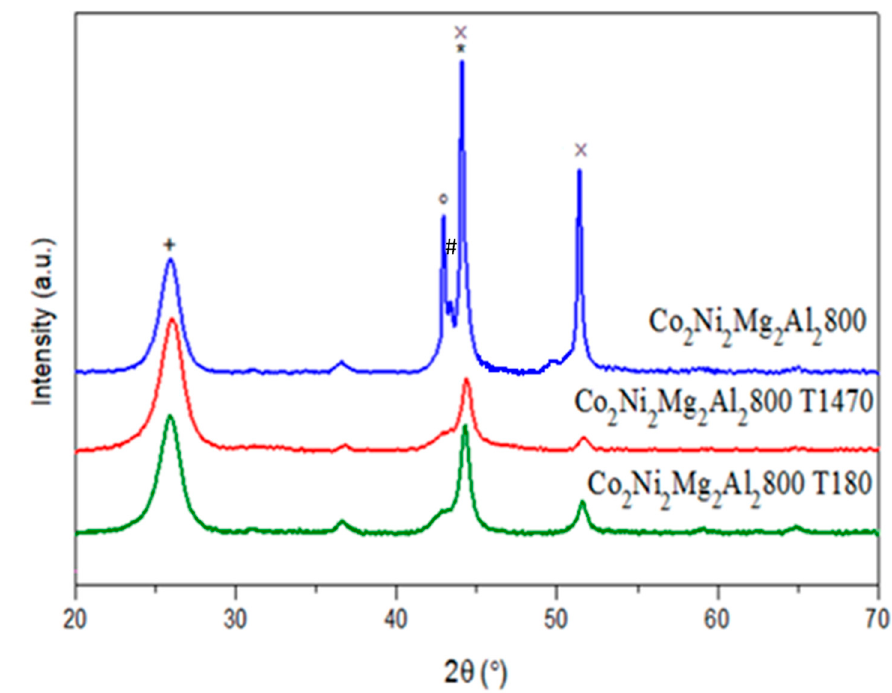
Figure 14. XRD patterns of Co 2 Ni 2 Mg 2 Al 2 800 after test in the presence of toluene (* C cubic JCPDS N ◦